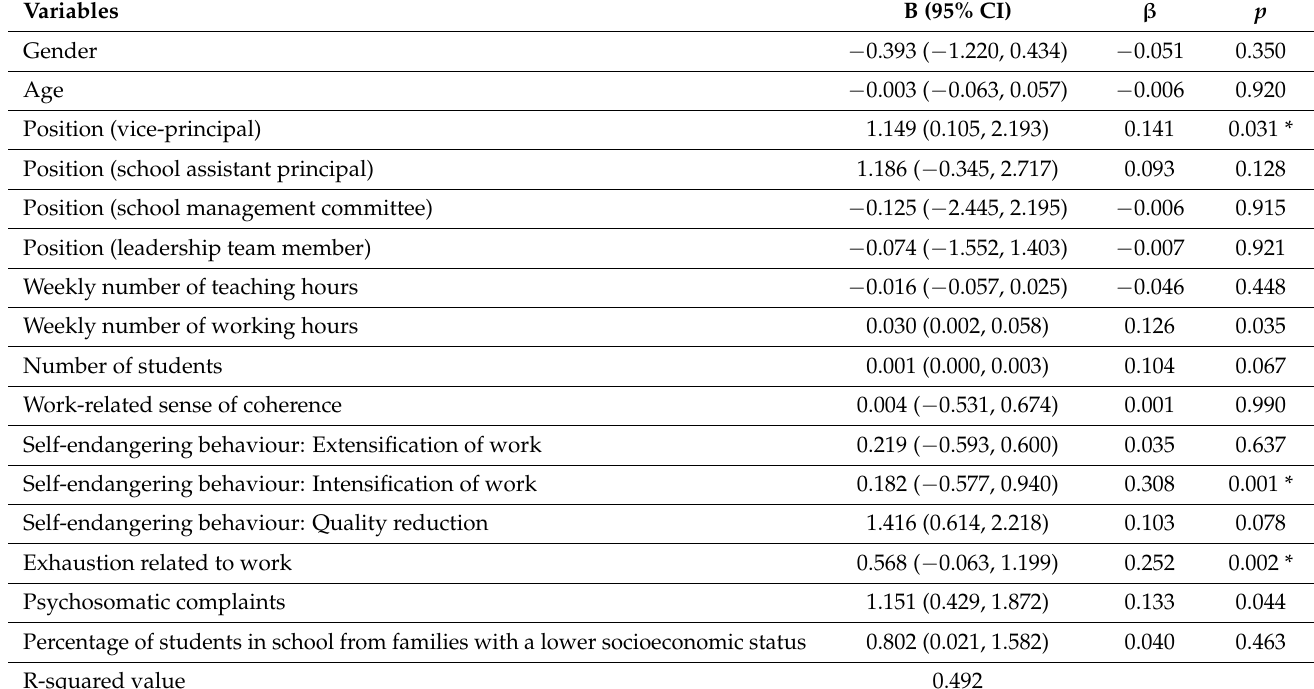
Table 3. Factors associated with the level of perceived stress via multiple linear regression